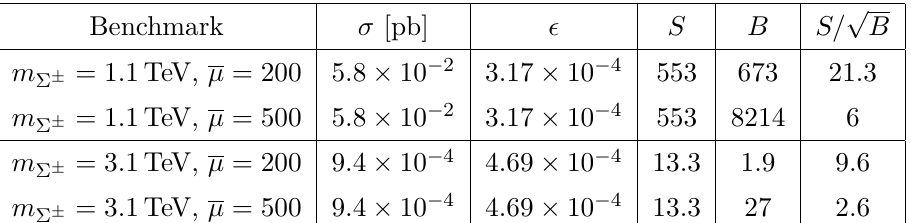
Table 1 . Cross section, overall event efficiency (cid:15) , number of expected signal (background) events S ( B ) with = 30 ab − 1 and significance S/ √ B at a 100 TeV pp collider for two benchmarks with L , cτ ( m ) = ( 1 . 1 TeV, 59 . 96 mm) and ( m Σ ± χ ± 1 represents the average number of pp interactions per bunch crossing. See the text for